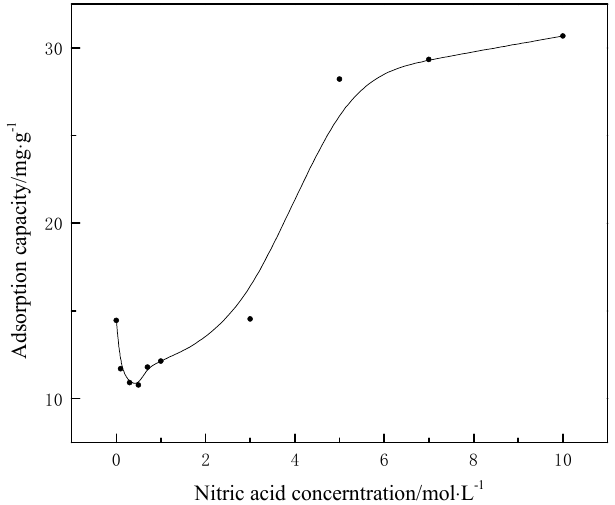
Figure 12. The change in Pb 2+ adsorption capacities with the modified concentration of nitric acid.